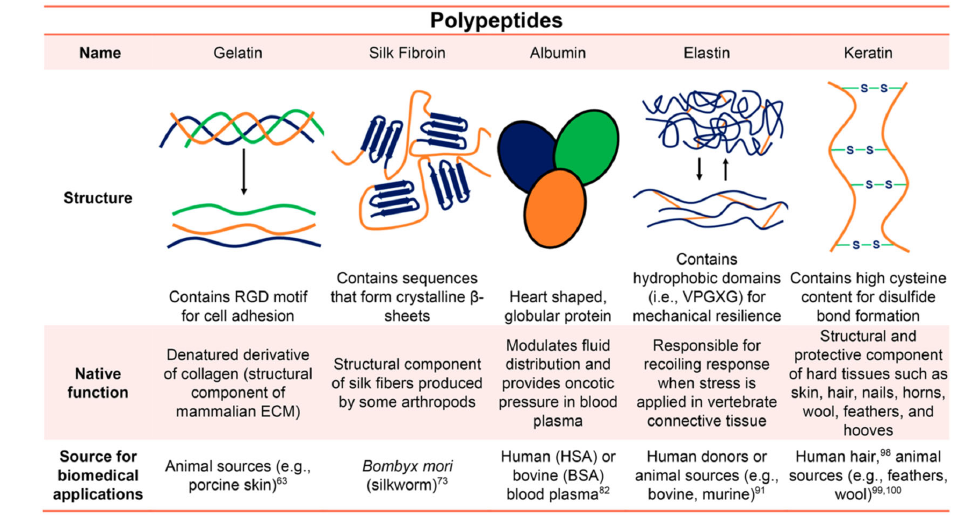
Figure 5. Polysaccharide-Based Biopolymers a . Reprinted with permission from Ref. [98]. Copyright 2015, American Chemical Society.